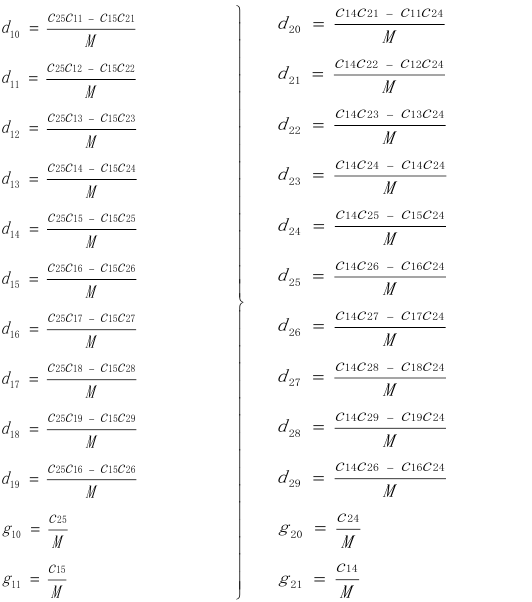
The measurement error of the perspective centre is 6 m (POS adopts non-differential GPS position in real-time); the measurement error of IMU is: heading angle 0.02 °, pitch angle 0.01 ° and roll angle 0.01 °. The global ASTER GDEM data of 1:50000 scale is selected in single-ray back-projection, which adopts WGS84 coordinate system, and its grid interval is 1 m and elevation accuracy is 7 m . The image point measurement error is generally 0.5 pixel, and the focal length error is 1 pixel. According to the oblique ULF-SVF-WC system design index in 2.1, the MSE of relevant parameters ( M ) are shown in Tab. 2. Basic Parameters